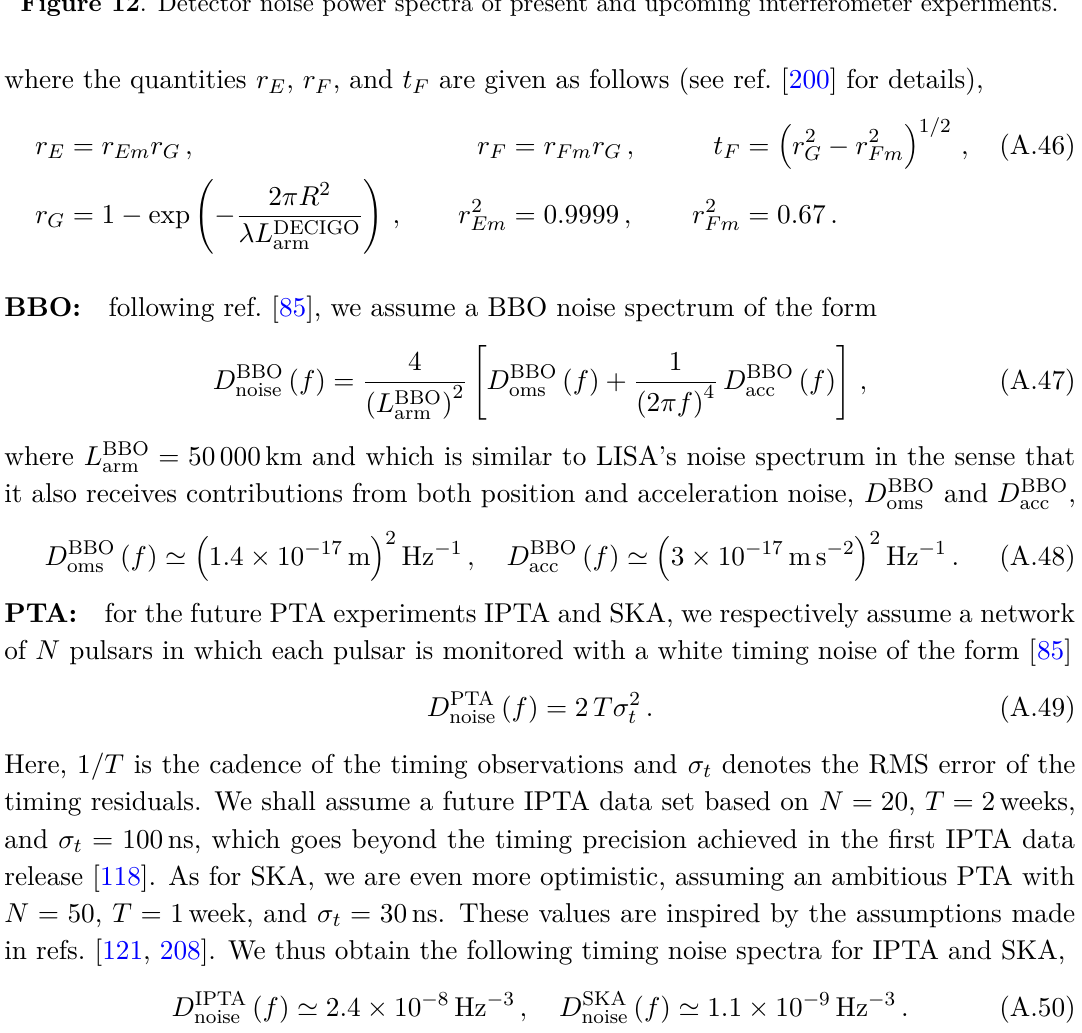
Figure 12 . Detector noise power spectra of present and upcoming interferometer